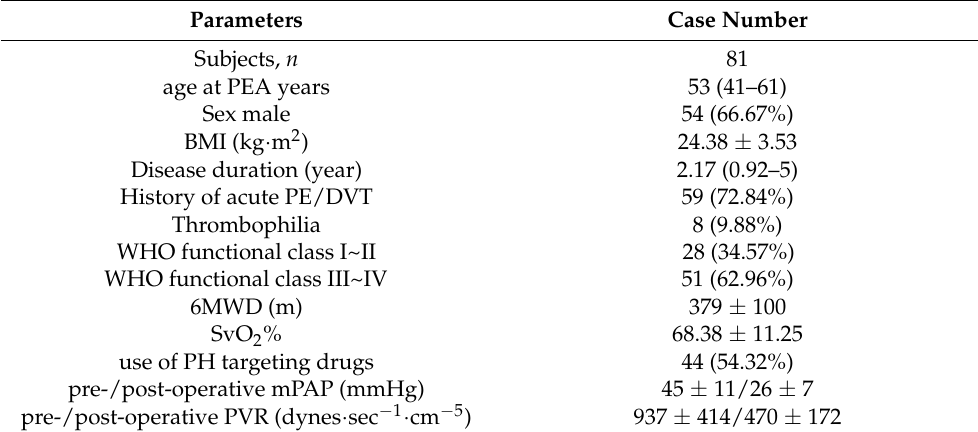
Table 1. Study population